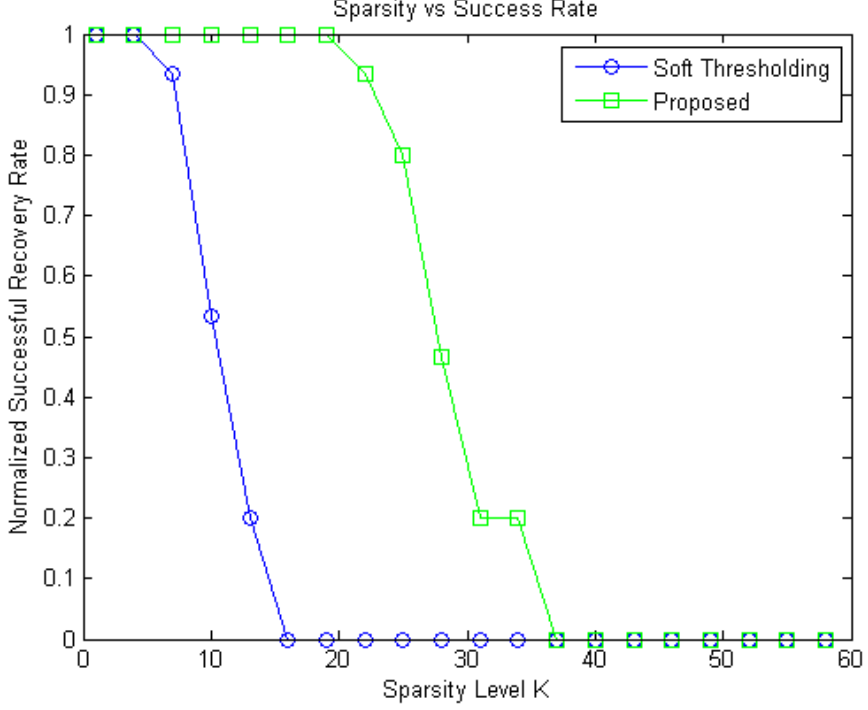
Figure 6. Sparsity effect on successful recovery achieved by the soft thresholding and proposed algorithm. The proposed algorithm performs much better even with higher sparsity level as compared to the soft thresholding technique.